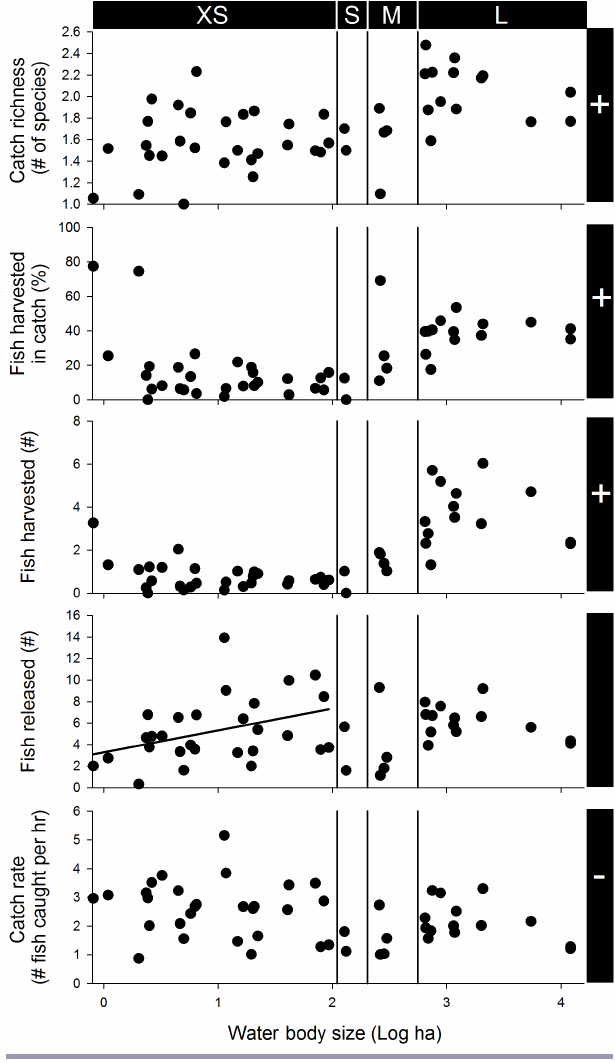
Fig. 4 . Bivariate plots between water body size (Log transformed ha) and party attributes (each dot represents a single water body) across unscaled data (all water bodies) and scaled data (extra small and large water body groups). Water body groups (XS = extra small, S = small, M = medium, L = large) are listed at top and separated by vertical lines. Party attributes include party size, time fished, boat anglers, in-state anglers, and trip distance. Significant relationships for unscaled data are depicted in the right black sidebar for each plot (positive relationship = +, negative relationship = -, no relationship = no sign). Significant relationships for scaled data are depicted by trend lines within each plot (no trend line = no relationship).